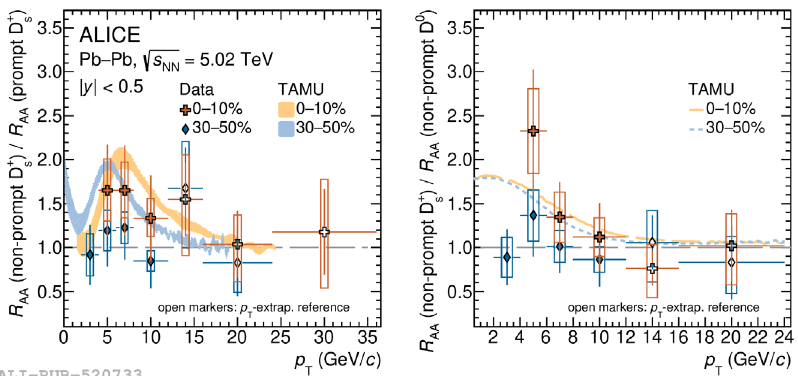
Figure 2. The R AA of non-prompt D + s meson divided by the one of prompt D + s meson (left panel) and non-prompt D 0 meson (right panel) for central and semi-central Pb–Pb collisions at √ s NN = 5.02 TeV [9]. The measurements are compared with TAMU model predictions Figure 1. Non-prompt to prompt